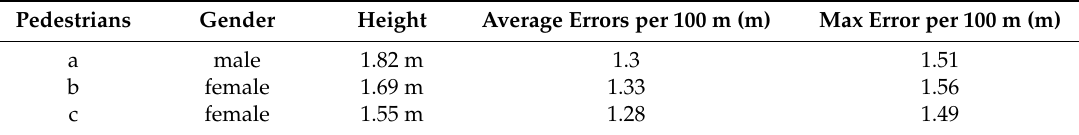
Table 2. Errors with PDR in the hybrid system.